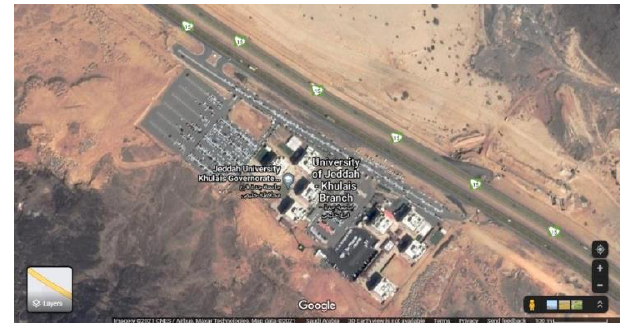
Fig. 1. Satellite image for the Khulais branch (Source: Google